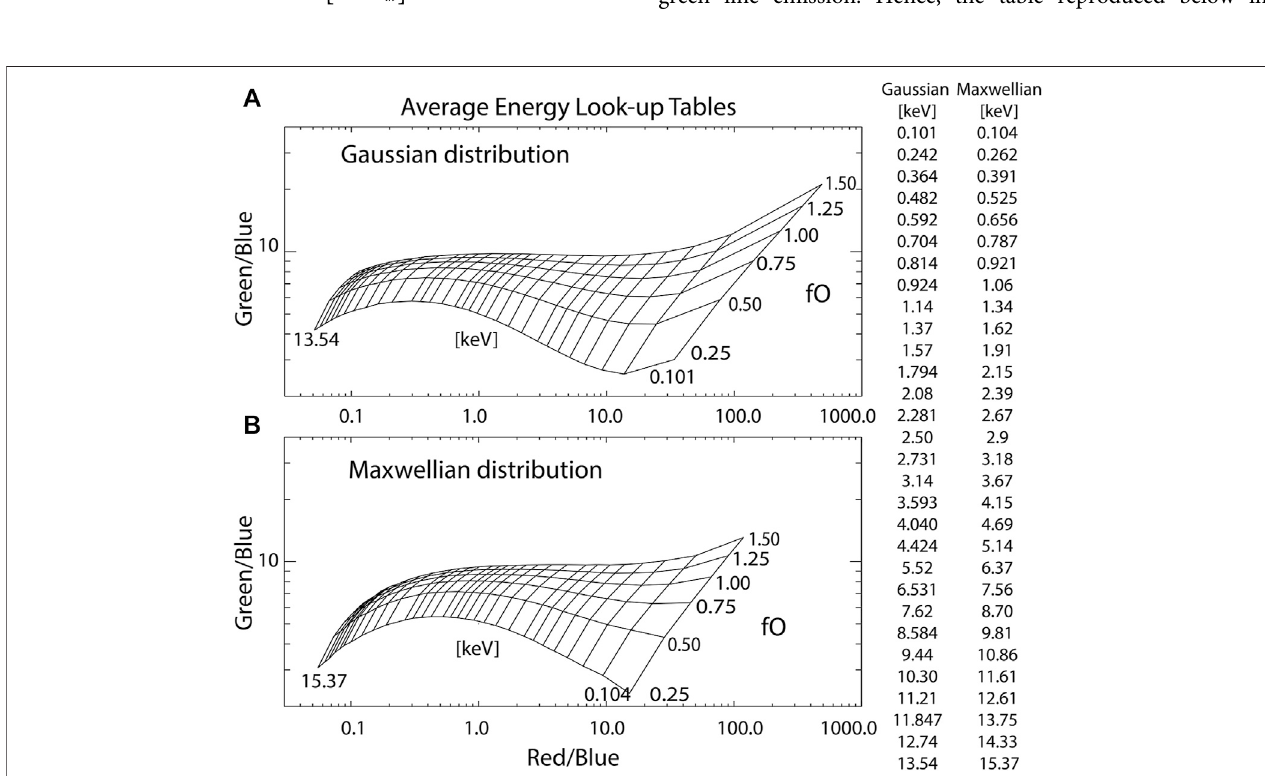
FIGURE 2 | Plots of E and fO as a function of the green/blue vs. red/blue ratios for a MSIS90 atmosphere (daily Ap of 22, F10.7 of 85.5 and average F10.7 of 84.7 over Fort Smith, Canada) for electron precipitation characterized by (A) a Gaussian energy distribution with high and low energy tails [28] and (B) a Maxwellian energy distribution. Averageenergies(E)are represented bythesemi-vertical lines and arelisted ontheright forboth distributions.The fOvalueislisted atthe endofeach semi- horizontal line.